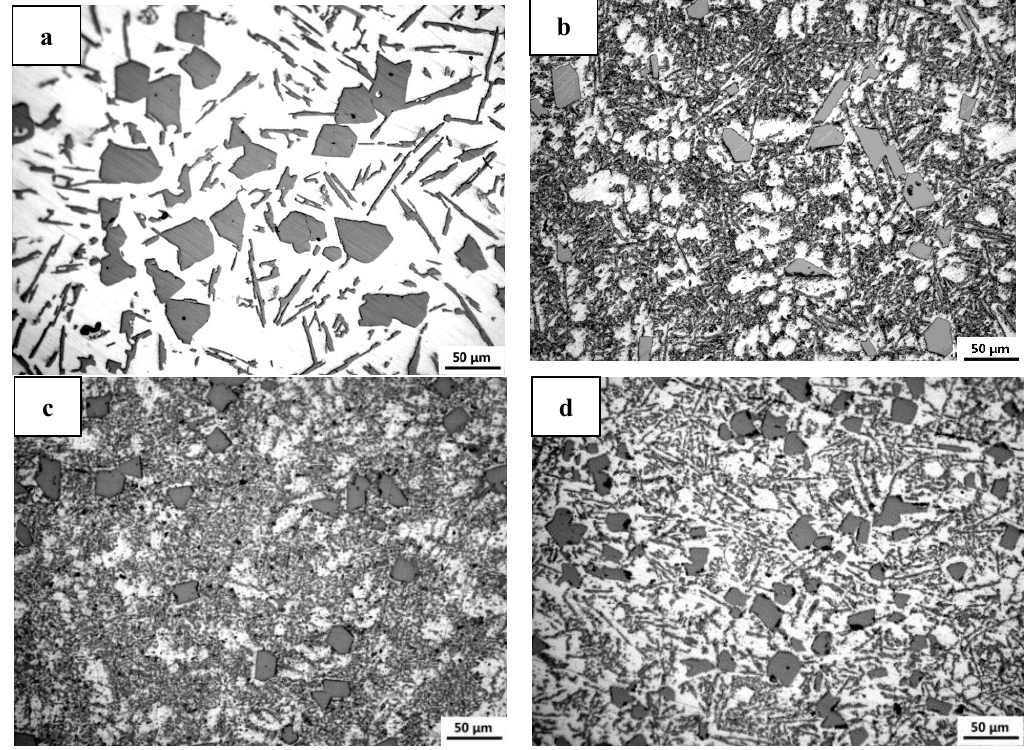
Figure 2. Microstructures of Al-17%Si alloy ingots with different content of FSM master alloys: ( a ) 0%; ( b ) 10%; ( c ) 20%; ( d )